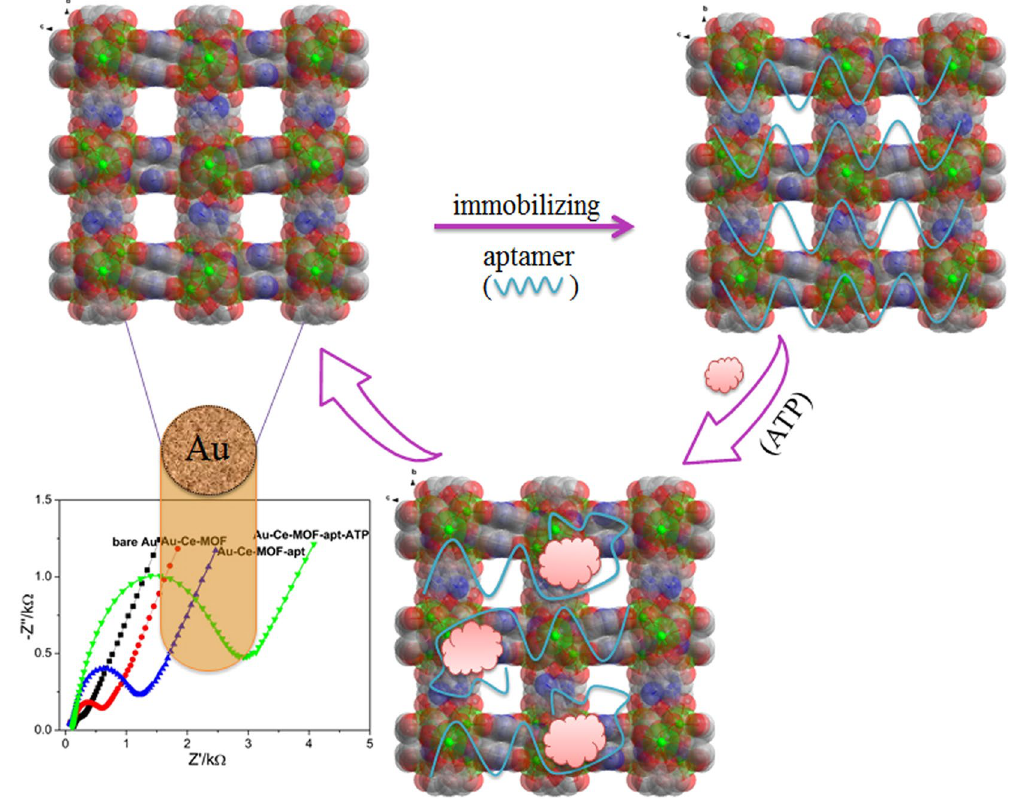
Figure 1. Schematic illustration of the label-free electrochemical sensor for ATP based on